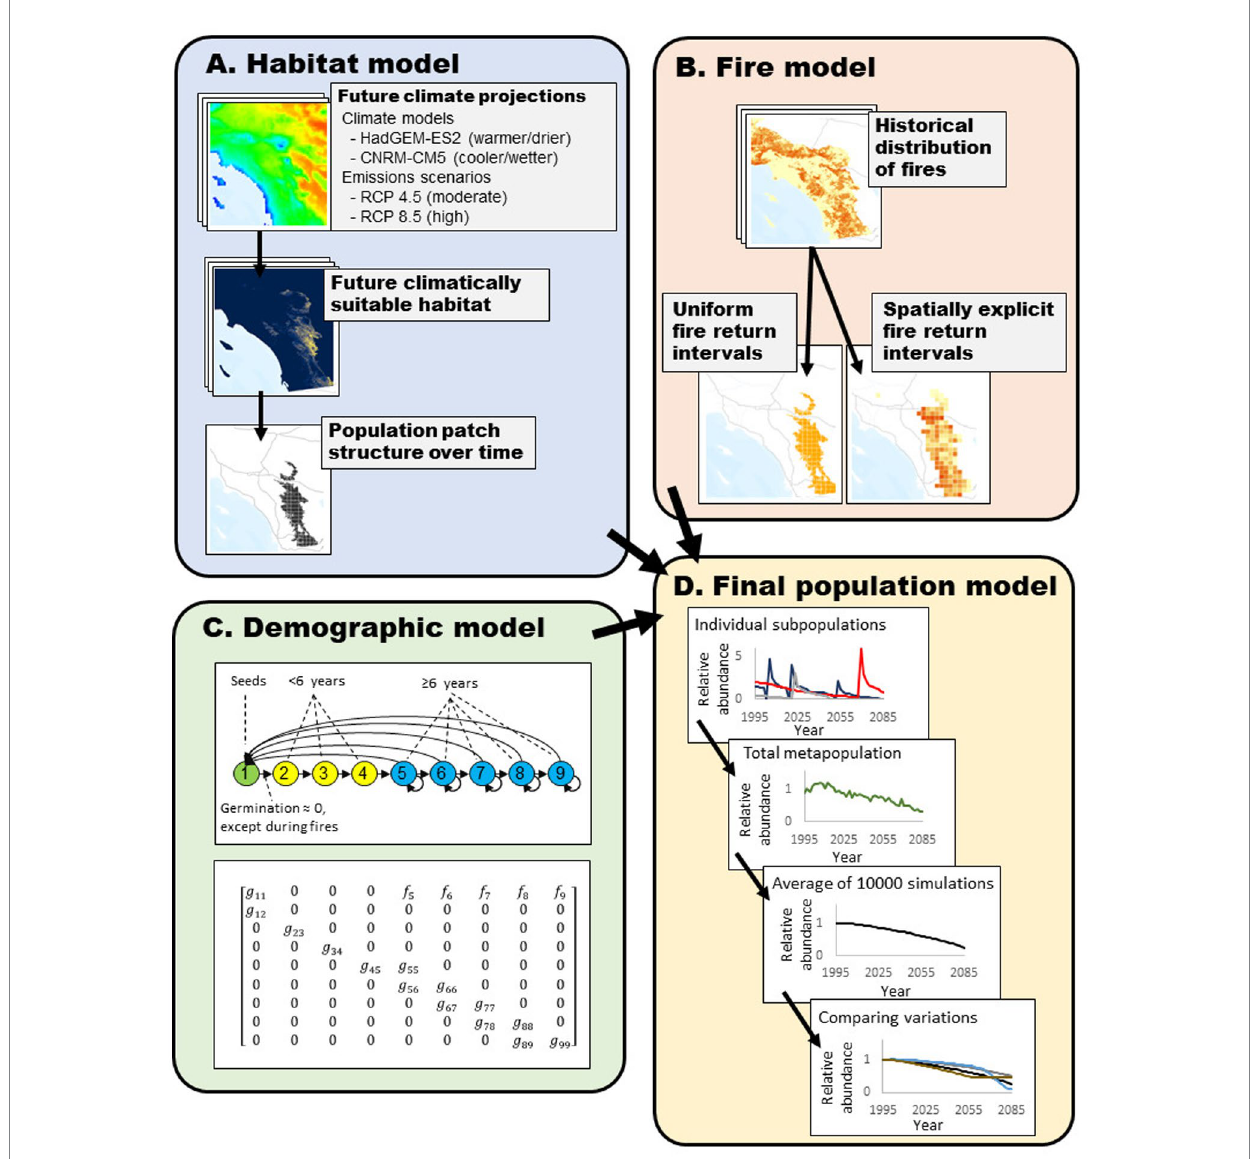
FIGURE 1 Simulations of Ceanothus perplexans were a combination of a species distribution model, spatially explicit fire patterns, and a matrix-based population model. (A) To build the spatial patch structure of the model, the initial and future suitable habitats were built from a species distribution model. Future climate models came from two general circulation models and two emissions scenarios. We split suitable habitat into smaller patches where we simulated subpopulation dynamics. (B) Using historical records of fires in California, we estimated a spatially explicit map of mean fire return intervals. We divided this into patches the size of simulated subpopulations and used this as a baseline for spatially explicit fire heterogeneity and modified it to reflect changing fire regimes. (C) We simulated the population dynamics in each patch stage-structured demographic model. Seeds only germinated after fire events. (D) Combining these together, we compared final populations among several combinations of climate and fire